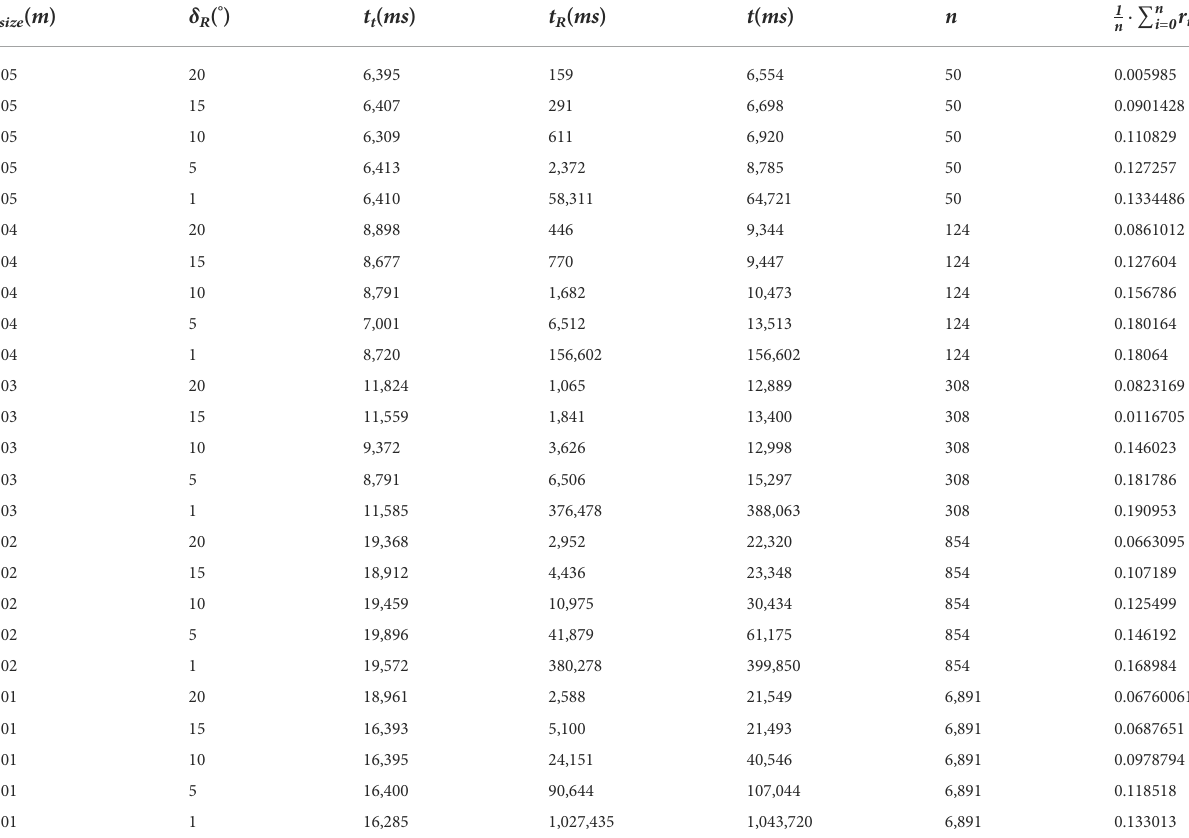
TABLE 1 RASSCMAP total generation time (t) for different voxel size (v size ) and rotation discretization ( δ R ), along with the time for the fi rst (t t ) and second part of the algorithm (t R ), the total number of points (n), and the average capability of the full